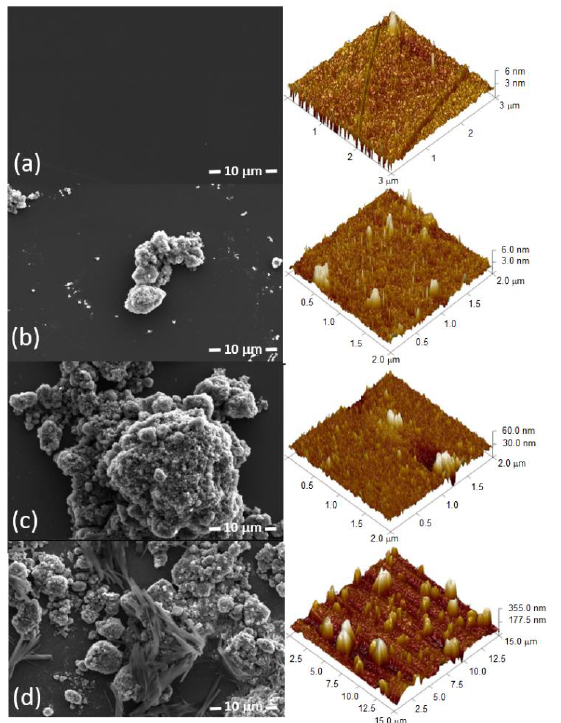
Figure 2. Morphological studies by SEM ( left ) and AFM ( right ) for ( a ) GC, ( b ) GC + GPH, ( c ) GC ox + GPH ox and ( d ) GC ox + GPH ox + Co(II)OEP systems.